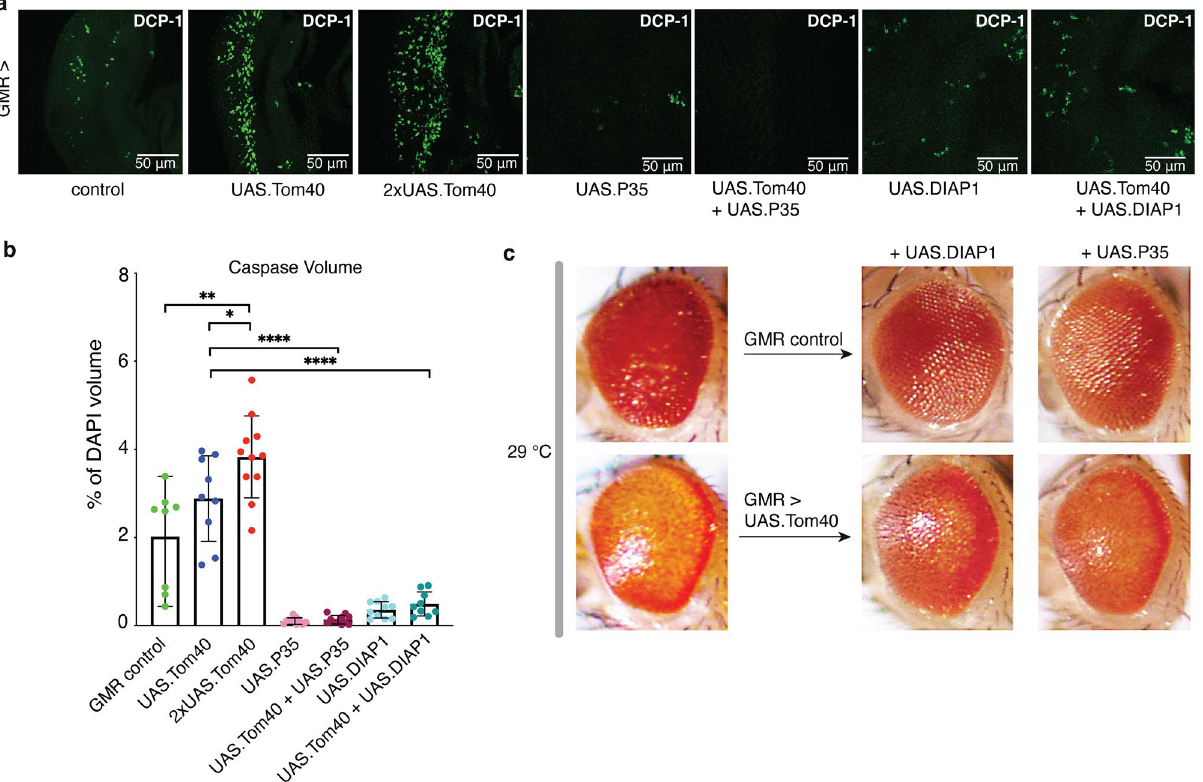
Figure 2. Tom40 overexpression activates caspase-dependent cell death. ( a ) Representative larval eye disc images stained with anti-cleaved DCP-1 (green), from left to right: control GMR-GAL4 (n = 8), single-copy UAS.Tom40 (n = 9) and double-copy UAS.Tom40 (n = 11), UAS.P35 (n = 10), UAS.P35 + UAS.Tom40 (n = 11), UAS.DIAP1 (n = 10), and UAS.DIAP1 + UAS.Tom40 (n = 9). ( b ) Quantification of cleaved DCP-1 proportional to tissue volume (determined using DAPI) mean volume ± SD (genotypes as labelled). ** denotes p = 0.0014, * denotes p = 0.0396, ****(upper) denotes p < 0.0001, ****(lower) denotes p = 0.0017, using unpaired t-test (< 0.05). ( c ) Representative images of adult eyes for genotypes as labelled. Rearing temperature as indicated. For each genotype, 8–10 flies were imaged using light